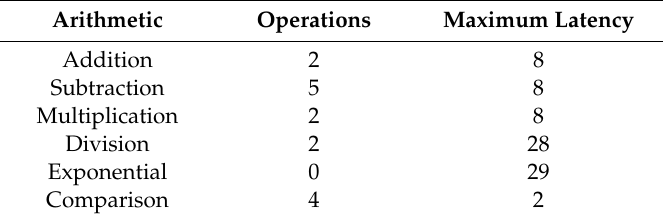
Figure 3. Optimized hardware mapping block diagram. Table 2. Optimized hardware mapping operation statistics.